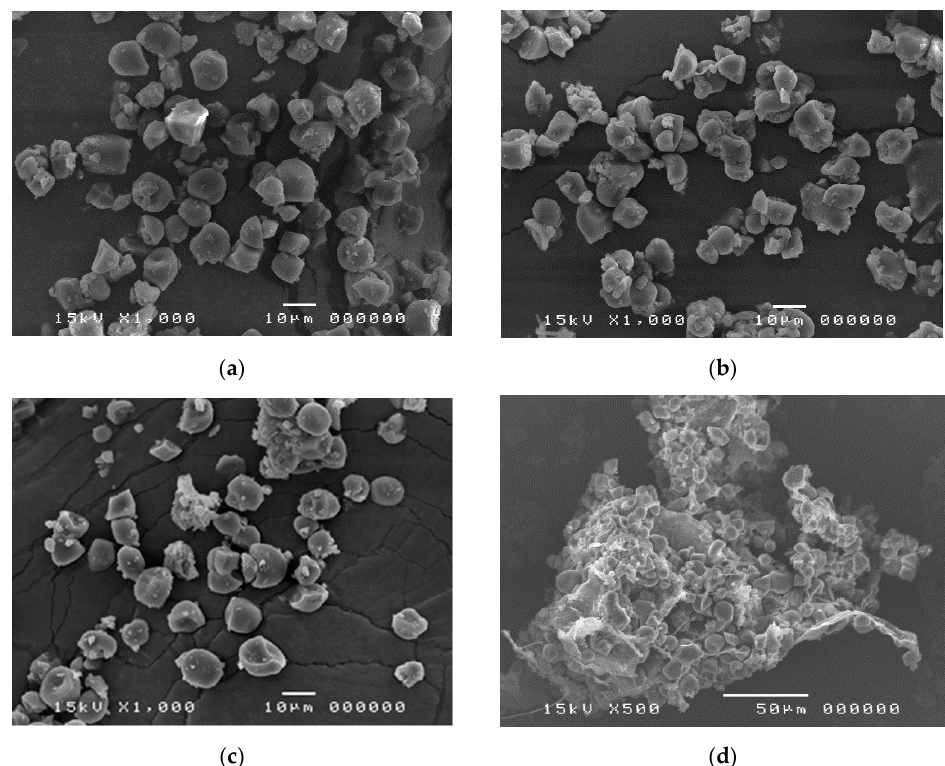
Figure 1. Representative SEM images of longan starches extracted from ( a ) seeds of fresh fruits (FLGS), ( b ) oven-dried fruits (DLGS), ( c ) “black longans” fruits, and ( d ) longan seed marc after extraction, showing that many starch granules remained intact.